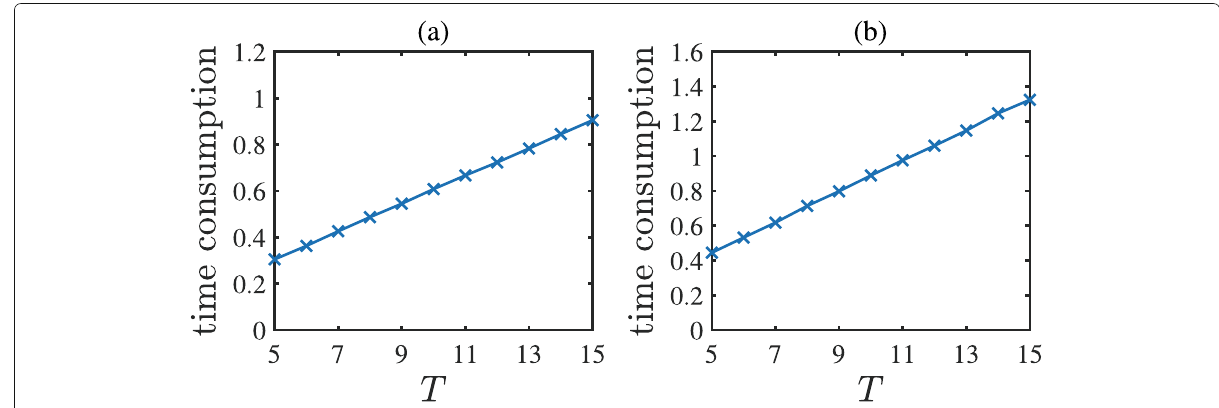
Fig. 12 Practical time consumption (seconds): (a) the result of Example 1, (b) the result of Example 2